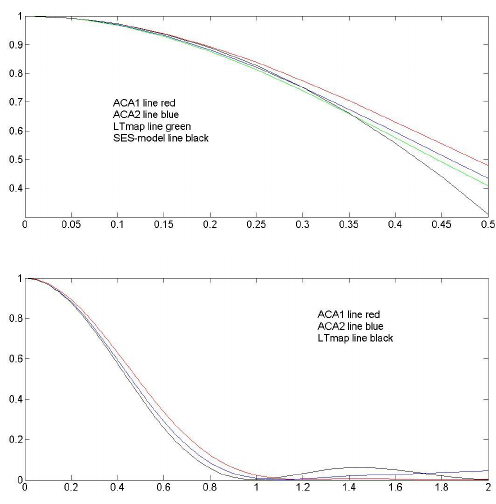
Fig. 5. Time variation of α DFA for ACA1 SES activity (blue circles). Time variation of α DFA for shuffled ACA1 time series (green diamonds). Inset: F(n) ∼ n relationship for ACA1 measured on 22 October 1993: the scaling behaviour indicates the presence of long-range correlations. EQ1 occurred on 24 October 1993.